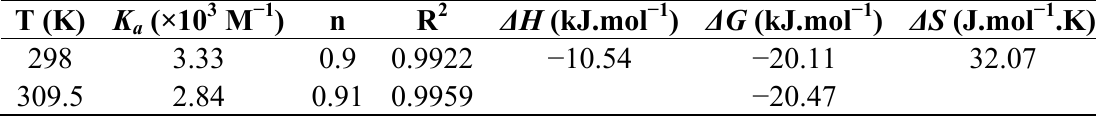
Table 2. The binding constants and thermodynamic parameters for BZF binding to